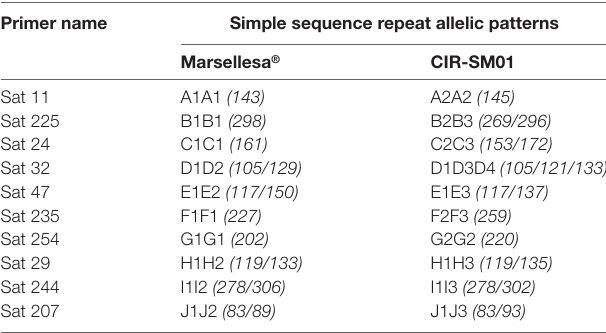
TABLE 9 | Simple sequence repeat allelic patterns observed for the two parents (Marsellesa ® and sterile male CIR-SM01) of the F1 hybrid Starmaya.